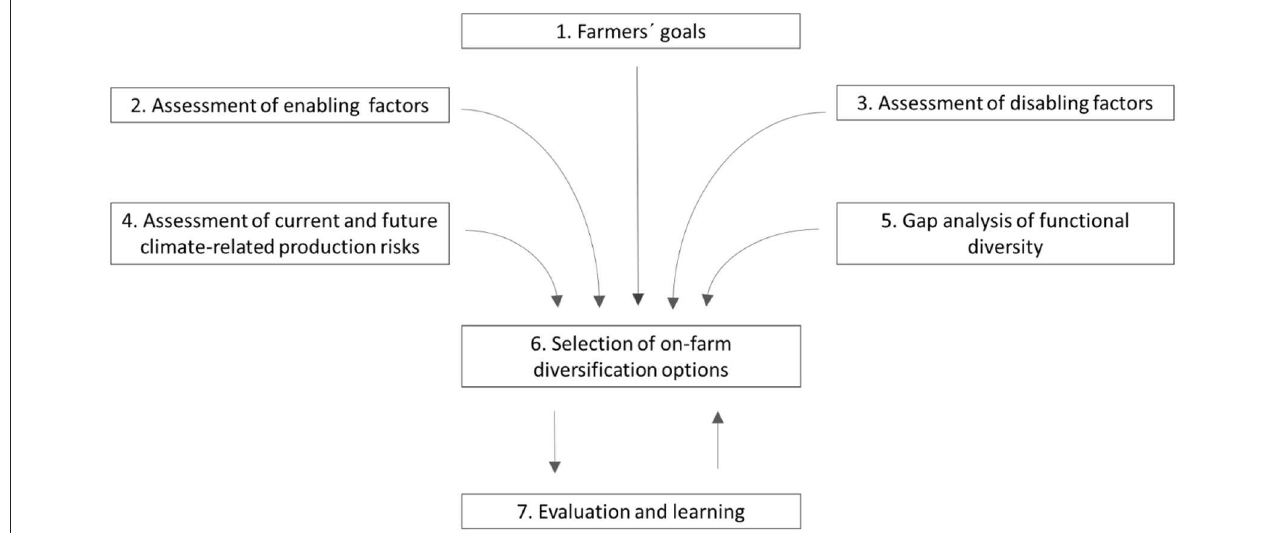
FIGURE 1 | Decision-making framework to develop, select, evaluate, and implement on-farm diversification strategies for climate change adaptation. We propose seven steps for practitioners and researchers to work with farmers in decision-making. Steps 1–5 help farmers and other actors to collect information to select on-farm diversification options in step 6. After the selection of on-farm diversification options, farmers can evaluate them in step 7 and implement or adjust them or replace them by other on-farm diversification options. This is reflected in a feedback loop between step 6 and 7. The arrows indicate which steps influence other steps in the decision-making